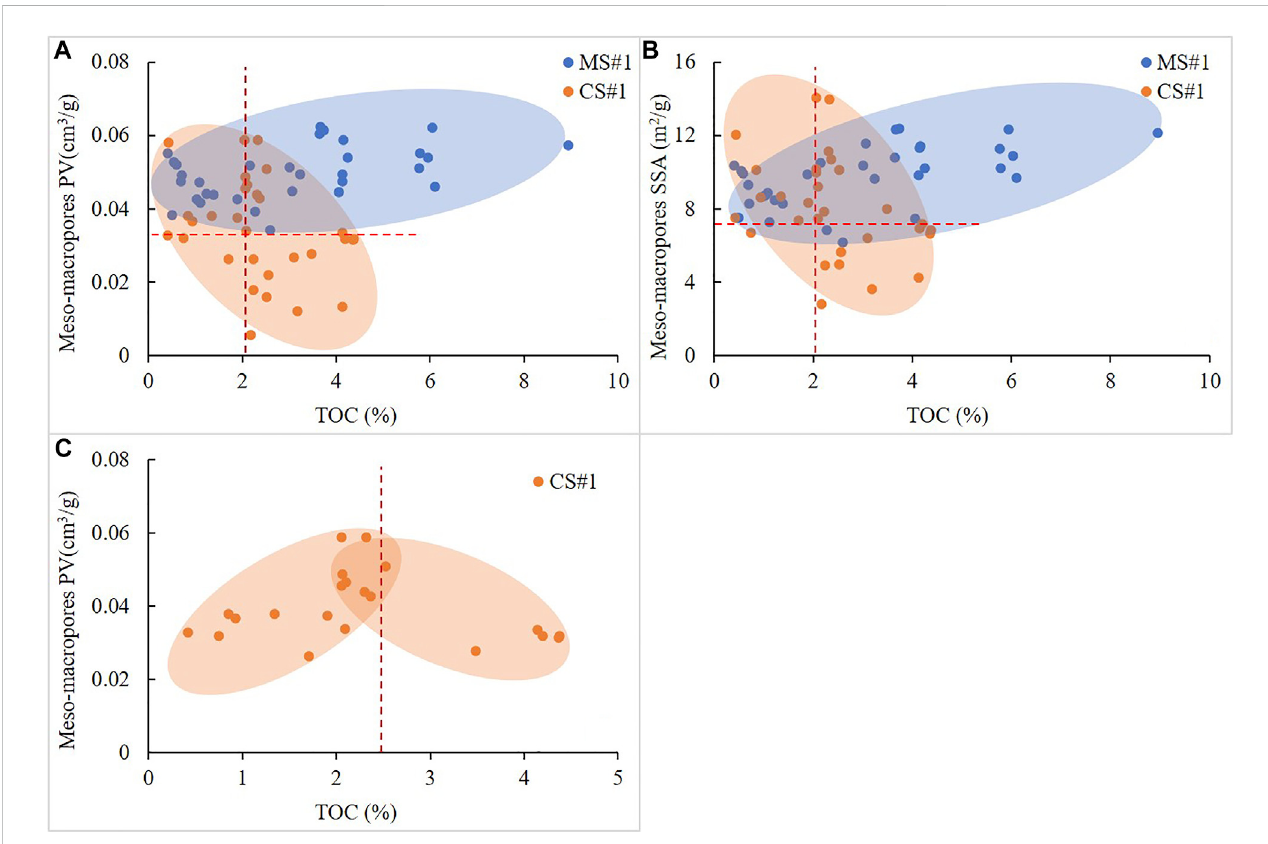
FIGURE 5 Relationship between TOC content and PV and SSA of meso-macropores of shales.